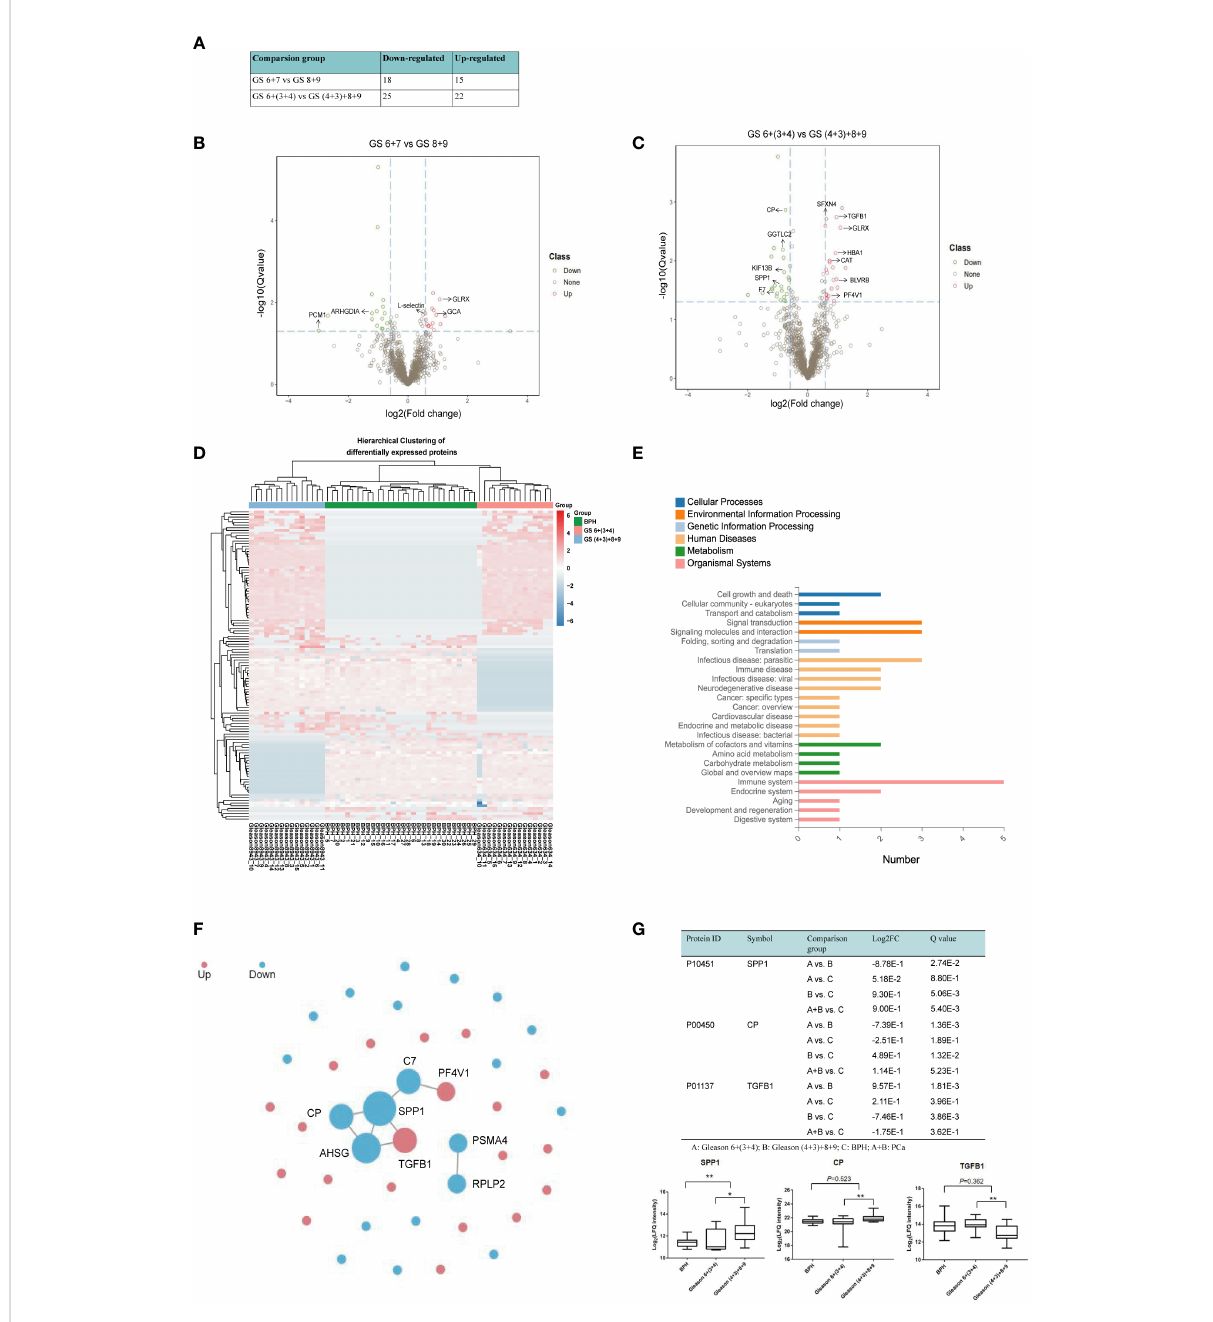
FIGURE 5 Quantitative differential analysis between AG and NAG patients. (A) Differential protein quantity of different comparison groups. FC >1.5 and Q value< 0.05 were selected by default for the signi fi cantly differential proteins. (B) Volcano map of the DEPs between GS 6 + 7 and GS 8 + 9 patients. Red and green dots represent up- and down-regulated proteins, respectively. (C) Volcano map of the DEPs between GS 6+(3 + 4) and GS (4 + 3)+8+9 patients. (D) The differences in DEPs were clustered. The X-axis represents the differential measure log2FC of the comparison group, and the Y-axis represents the protein. The redder the color block is, the greater the expression difference is, and the bluer the color is, the smaller the expression difference is. (E) The classi fi cation results of KEGG pathway annotation of differential proteins were plotted. The X- axis represents the number of proteins annotated to a certain KEGG Pathway category, and the Y-axis represents the KEGG Pathway category. (F) PPI network. Red represents up-regulated proteins, blue represents down-regulated proteins, and the circle size represents relationship intensity. (G) Box plot analysis of intensity values for selected proteins among BPH, GS 6+(3 + 4), and GS (4 + 3)+8+9. (* p <0.05, ** p <0.01. A: GS 6+(3 + 4); B: GS (4 + 3)+8+9; C: BPH; A+B: